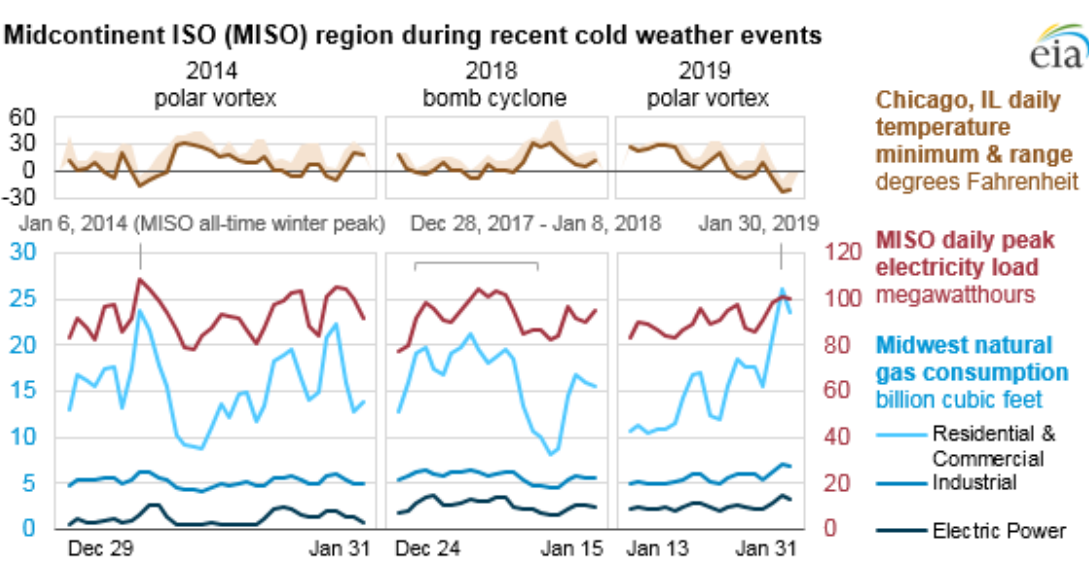
Figure 1. Historical temperature, electricity load, and natural gas consumption data for periods of extreme winter weather in the Midwest United States. Periods of extreme cold correspond with an increase in electricity and natural gas demand, which is primarily driven by residential and commercial heating. Source: U.S. Energy Information Administration [6].